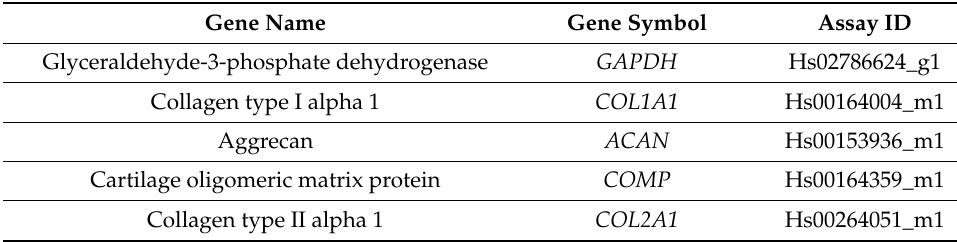
Table 1. TaqMan Gene Expression